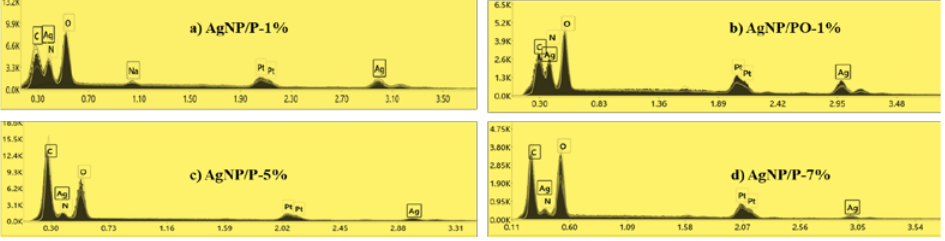
Figure 4. EDX spectra of synthesized silver nanoparticles: ( a ) AgNP/P-1%, ( b ) AgNP/PO-1%, ( c ) AgNP/P-5%, and ( d ) AgNP/P-7% observed at 3 keV binding energy for silver.